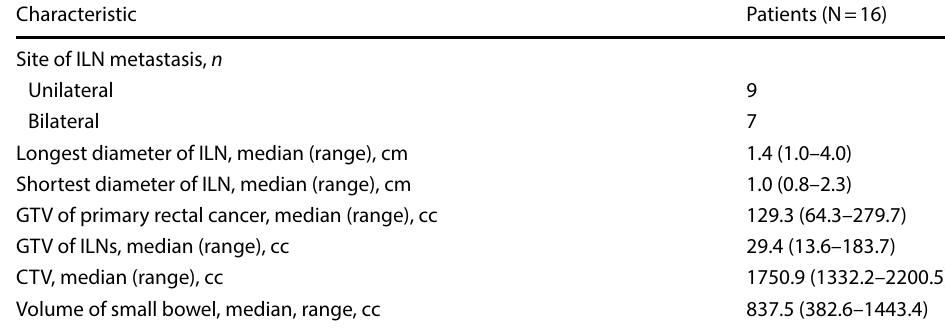
Characteristics of the ILN metastases (based on pre-treatment MRI/CT) and radiation target volumes of 16 patients who were diagnosed with LARC between January 2017 and December 2019, had synchronous SILNM and no distant metastases, and underwent nCRT with ILN radiation boost prior to TME. ILN charac- teristics based on MRI, EUS, and/or CT ILN, inguinal lymph node; LARC, locally advanced rectal cancer; SILNM, solitary inguinal lymph node metastasis; GTV, gross tumor volume; CTV, clinical target volume; MRI, magnetic resonance imaging; CT, computed tomography; nCRT, neoadjuvant chemoradiotherapy; TME, total mesorectal excision; EUS,